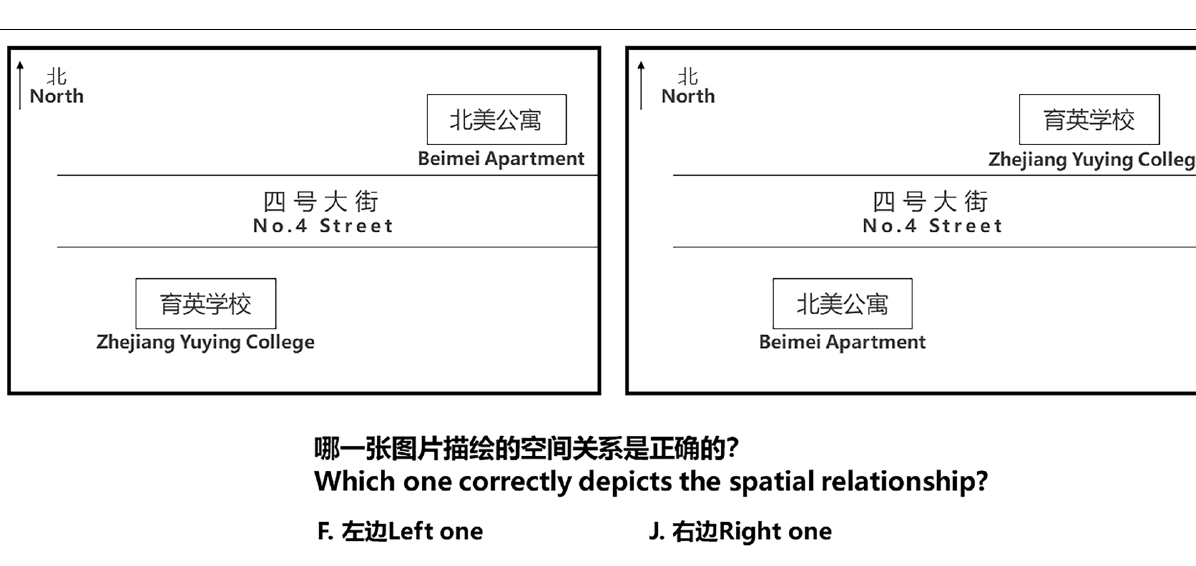
FIGURE 7 | Orientation judgment task: Task display.